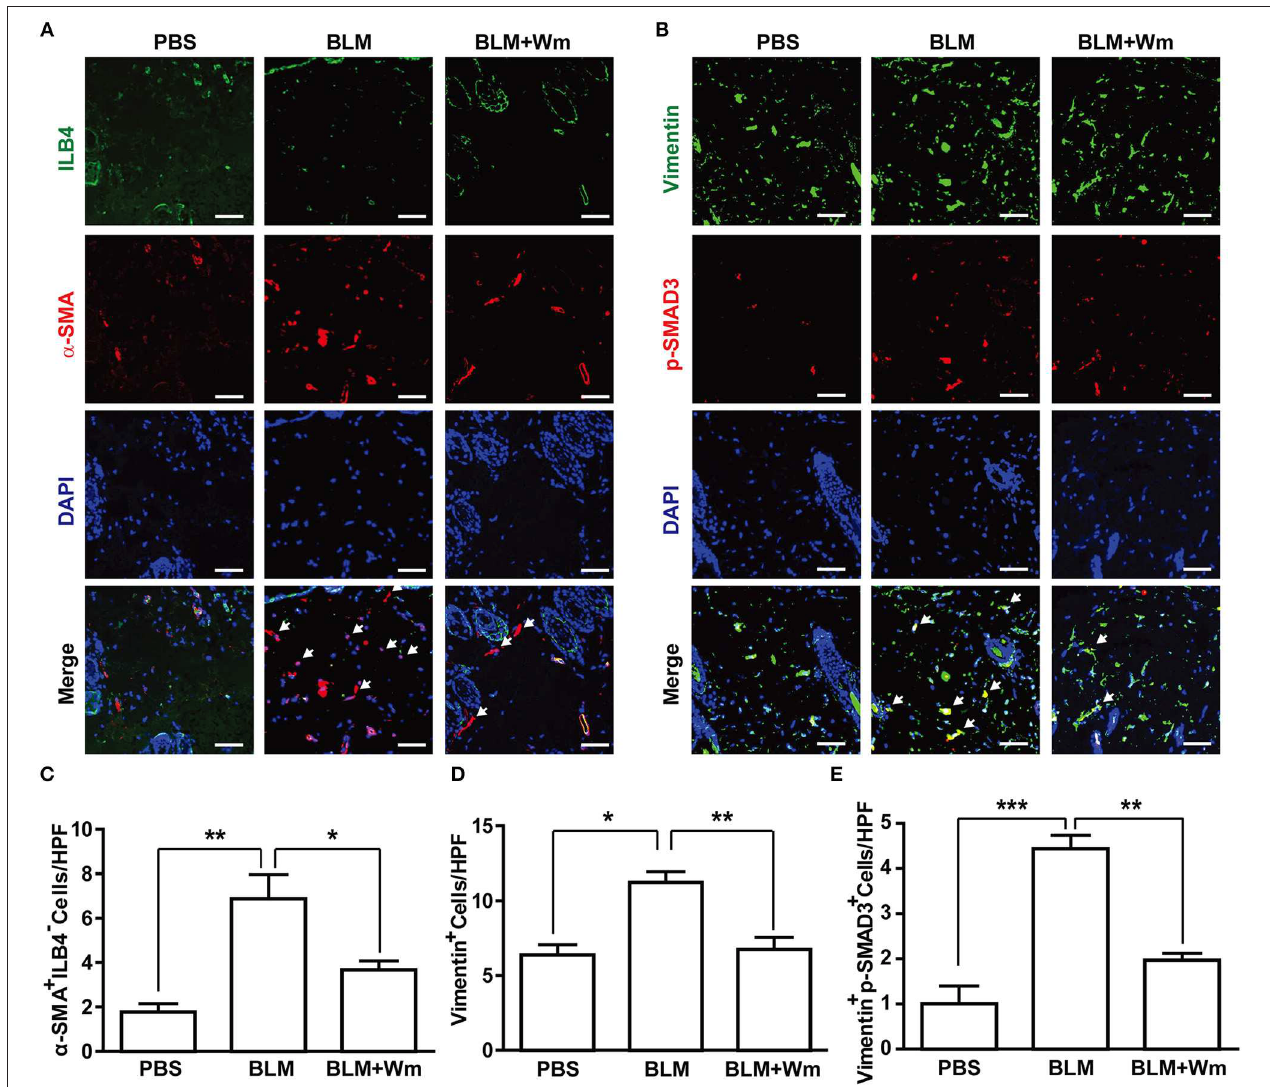
FIGURE 3 | Effects of WKYMVm treatment on myofibroblast differentiation in scleroderma. (A) WKYMVm-induced inhibition of myofibroblast differentiation in scleroderma. The BLM-induced scleroderma mice were treated with or without 1 µ M Wm for 3 weeks, and the mock-treated (PBS) and the scleroderma (BLM or BLM + Wm) skin specimens were immunostained with antibodies against α -SMA and ILB-4. (B) The skin specimens were stained with antibodies against Vimentin and phospho-SMAD3. Scale bar = 50 µ m. The numbers of α -SMA + ILB-4 − (C) , Vimentin + (D) , and Vimentin + phospho-SMAD3 + (E) cells were quantified under a high-power field. Data represent mean ± SD ( n = 8 per group). * p < 0.05, ** p < 0.01, *** p <